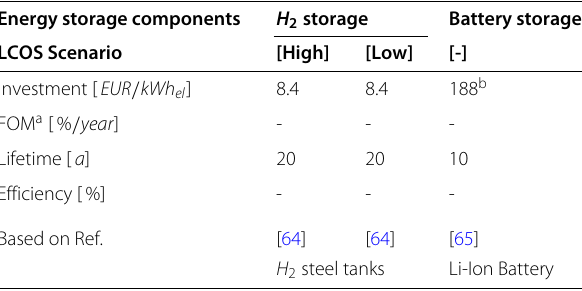
Table 2 Energy related energy storage model inputs representing 2030 data